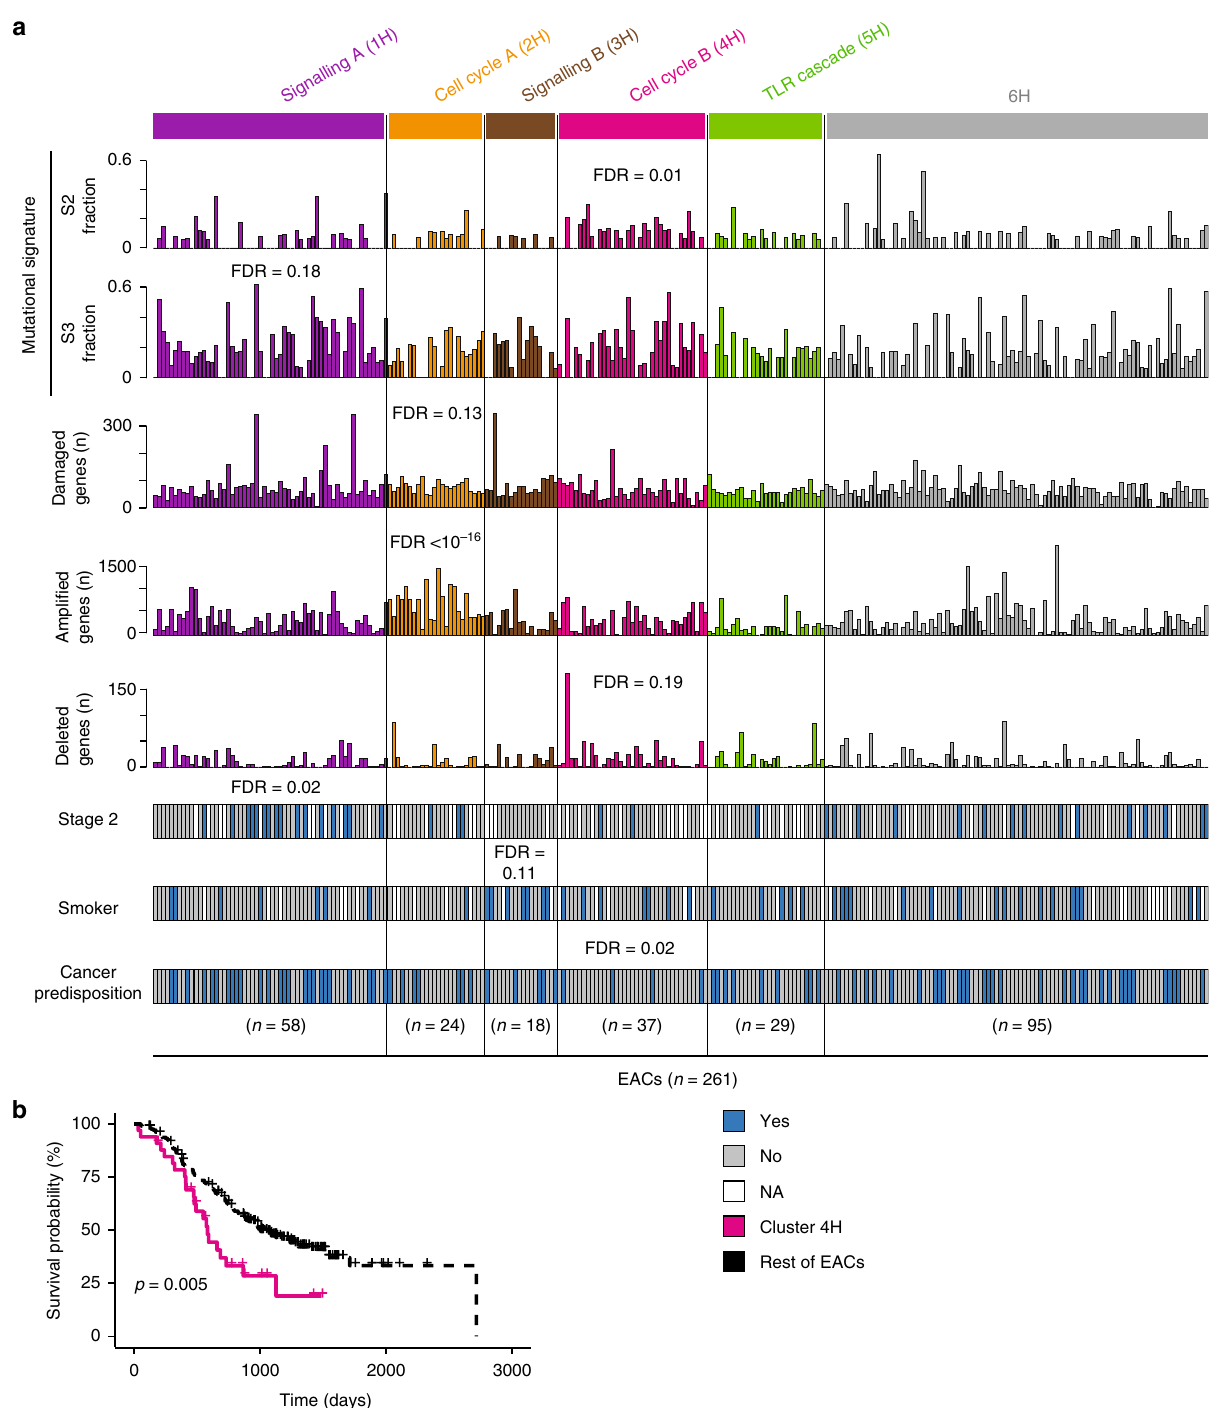
Fig. 3 Features of EAC clusters driven by pathways enriched in helpers. a For each helper cluster (1H-6H) indicated are the molecular features (mutational signatures, number of genes with damaging mutations, undergoing ampli fi cation or deletion), the distribution of stage 2 tumours and the tobacco smoking habits of the patients that show signi fi cant associations with one of the six clusters of helpers. Enrichment in number of altered genes, tumour staging, smoking habits and cancer predisposition was assessed using Fisher ’ s exact test. Distributions of mutational signatures were compared using Wilcoxon rank-sum test. FDR = false discovery rate after correction for multiple testing. b Kaplan – Meier survival curves of EACs in cluster 4H ( n = 37) and the rest of EACs ( n = 224). Analysis was performed using survival (https://github.com/therneau/survival) and survminer (https://github.com/kassambara/ survminer) R packages with default parameters. Signi fi cance was measured using the log-rank